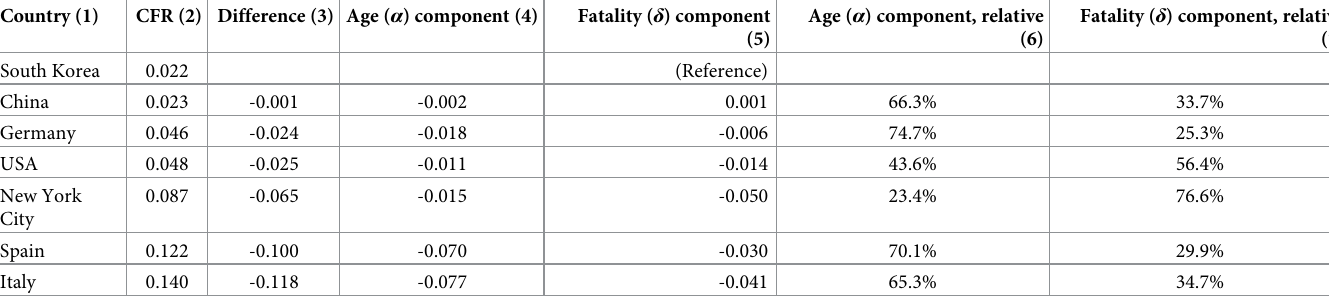
The third column shows the difference between each country and South Korea, and is calculated as the CFR of South Korea minus the CFR of the respective country. Data for all countries is for June 30, except China (February 11), Spain (May 21), and the United States (June